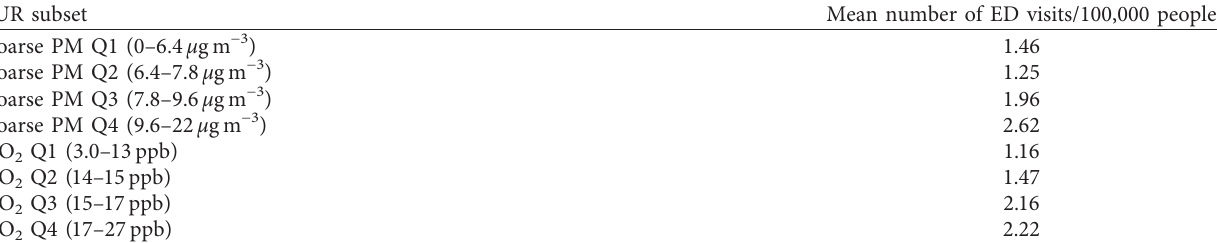
Table 1: Prevalence of population-adjusted pediatric emergency department visits for asthma, based on home location-based air quality levels. LUR subset